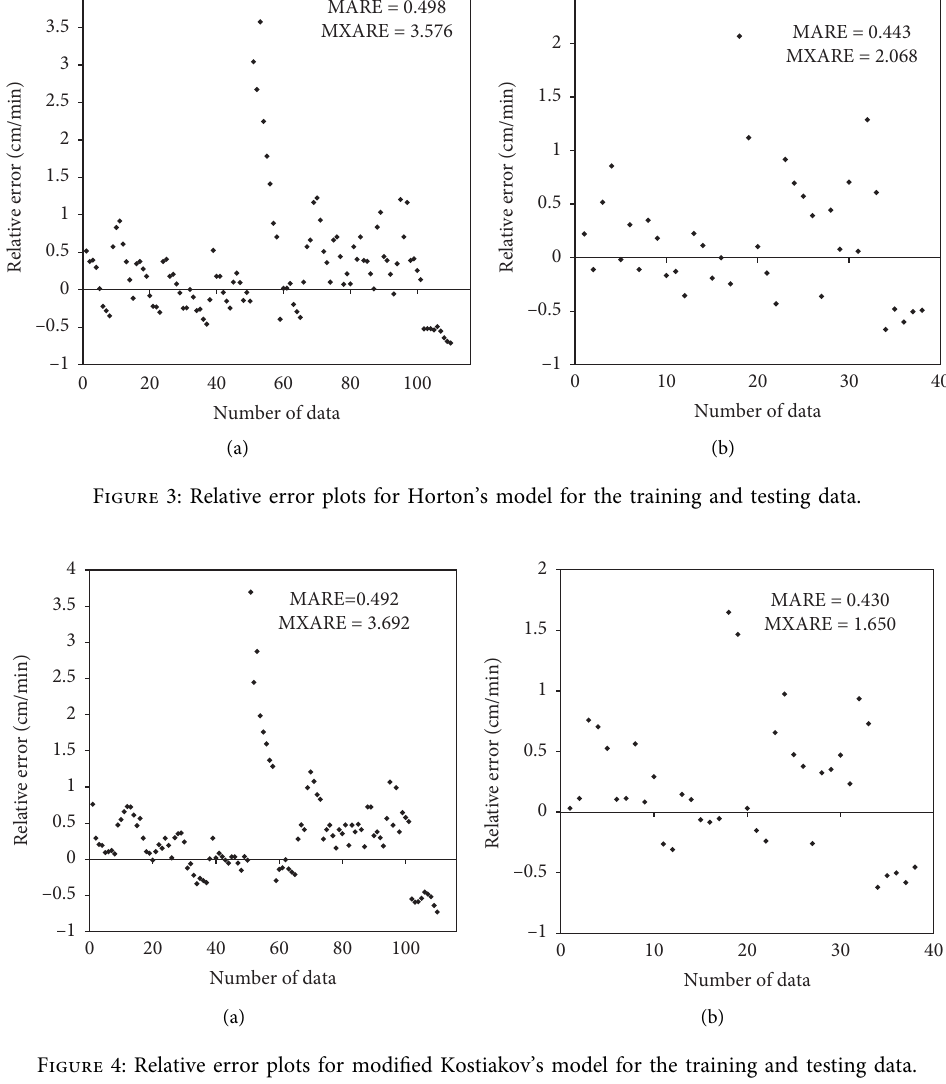
Figure 4: Relative error plots for modified Kostiakov’s model for the training and testing data.